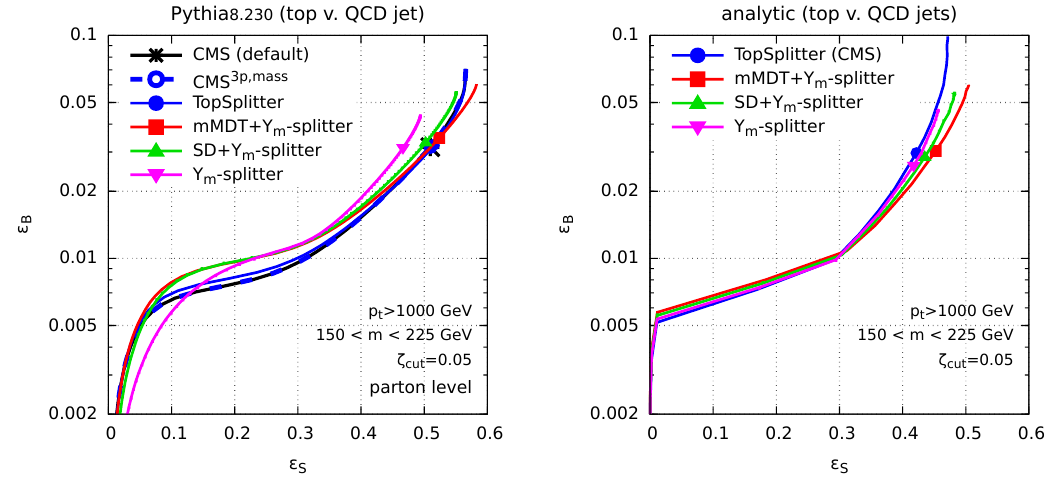
Figure 15. ROC curves obtained for 1 TeV top v. QCD jets when varying m min . For the analytic calculation we have assumed a quark fraction of 2 = 3, roughly corresponding to the matrix elements used in the Pythia simulation. The rest is as in (cid:12)gure